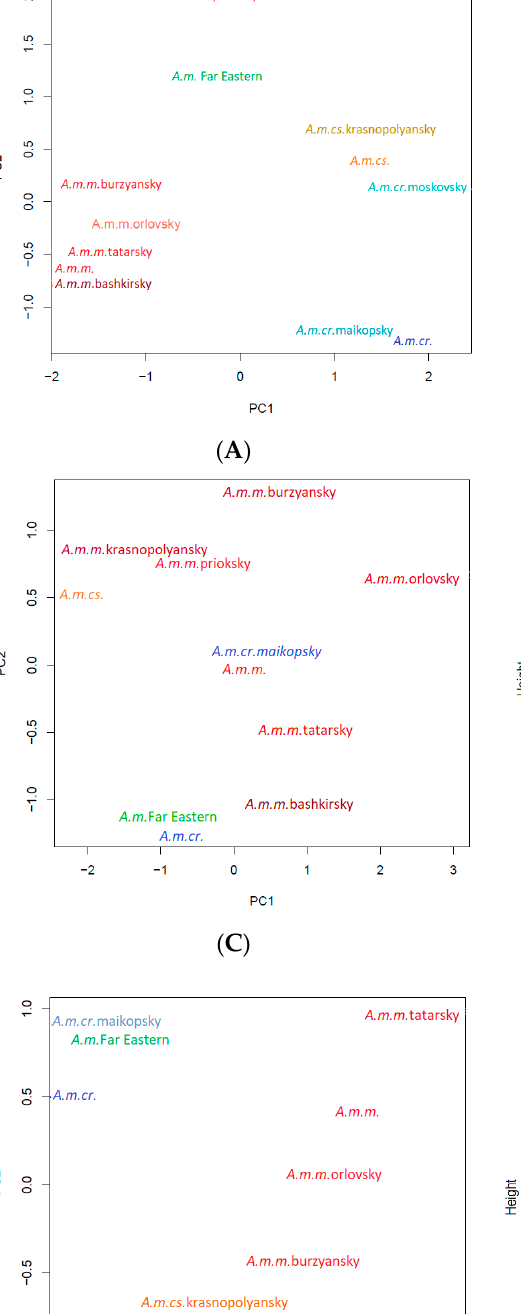
from breeds 1, 3 or 4. of honey bees, respectively.